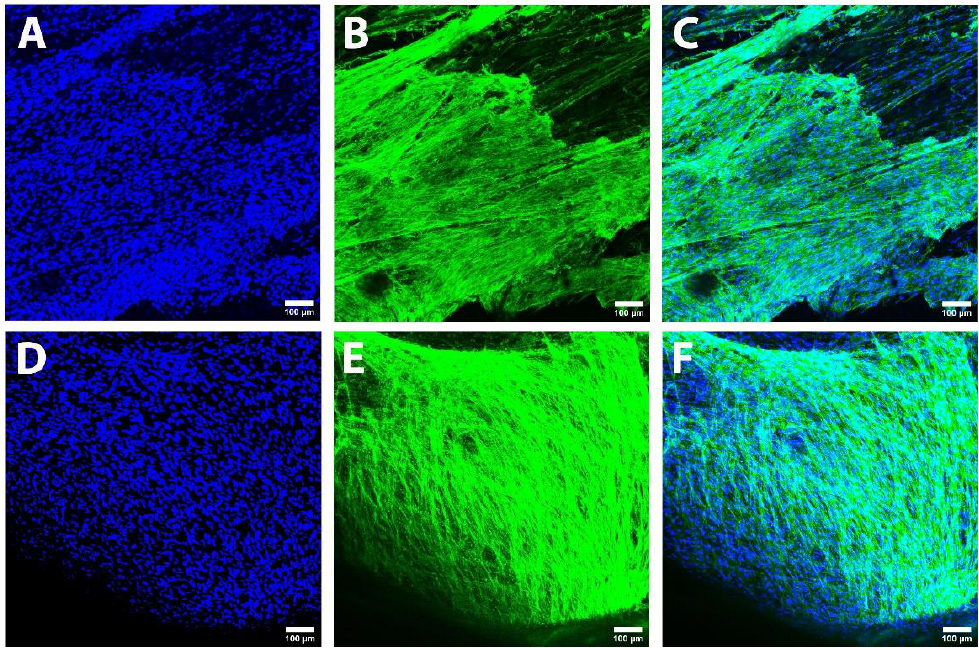
Figure 5. Confocal images of human Schwann cells (hSC) seeded on a multimodular conduit (MMC). ( A – C ) Images after the culture of 2.5 × 10 6 hSC for 5 days. ( D – F ) Images after the culture of 1.25 × 10 6 hSC for 10 days. The cytoskeleton of hSC is observed in green color (Phalloidin) and the nuclei of hSC is observed in blue color (DAPI). As can be seen, the cells have formed a sheath that fills the lumen of the HA conduit and that also covers the surface of PLA microfibers. A more continuous and thicker cell sheath is observed when 1.25 × 10 6 hSC are cultured for 10 days ( D – F ). Further, the higher degree of coating by hSC can be appreciated when using MMC instead of UMC (Figure S1).